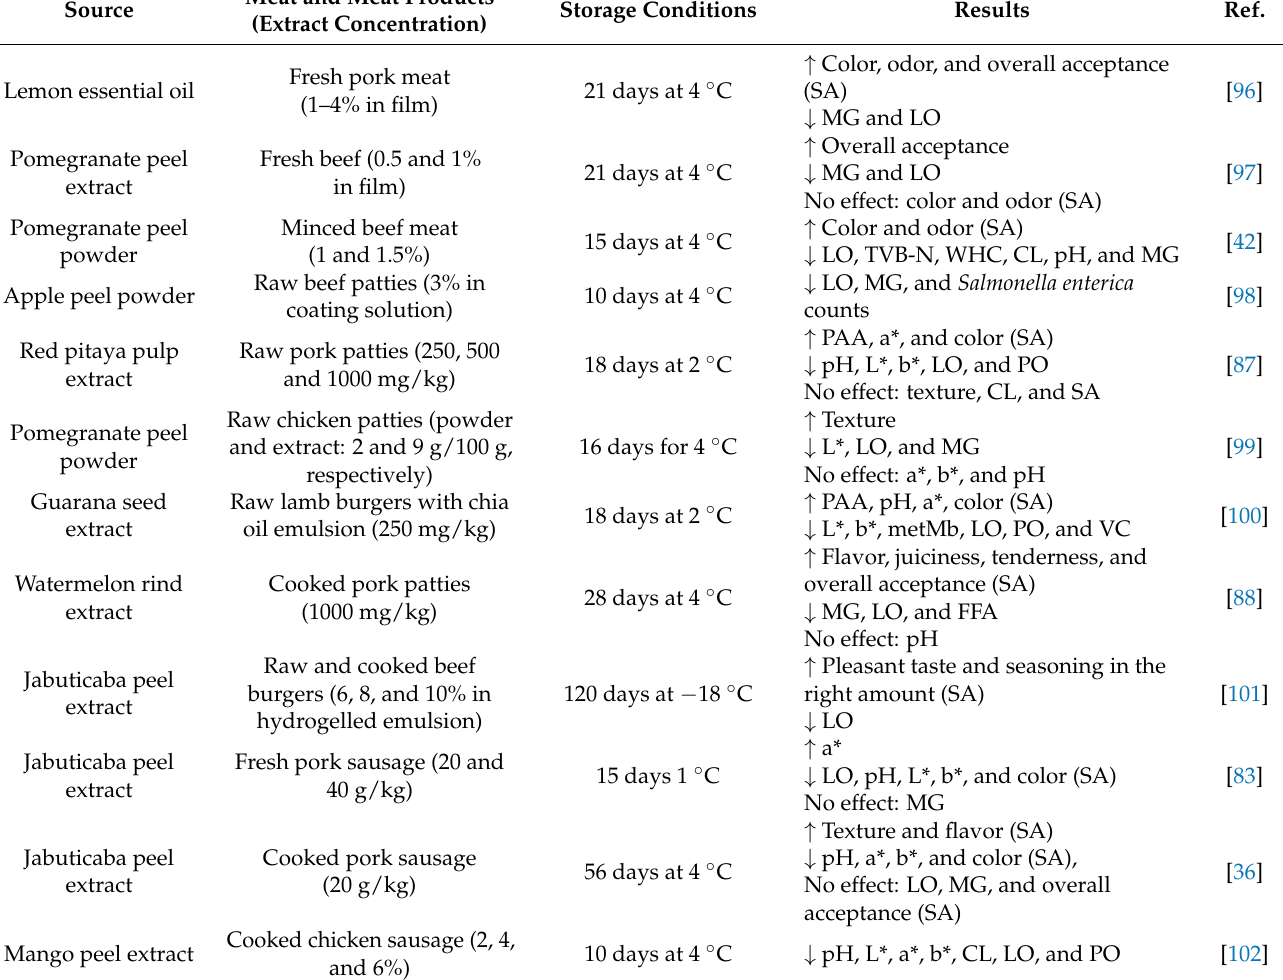
Table 4. Preservative effect of fruit bioactive compounds in meat and meat